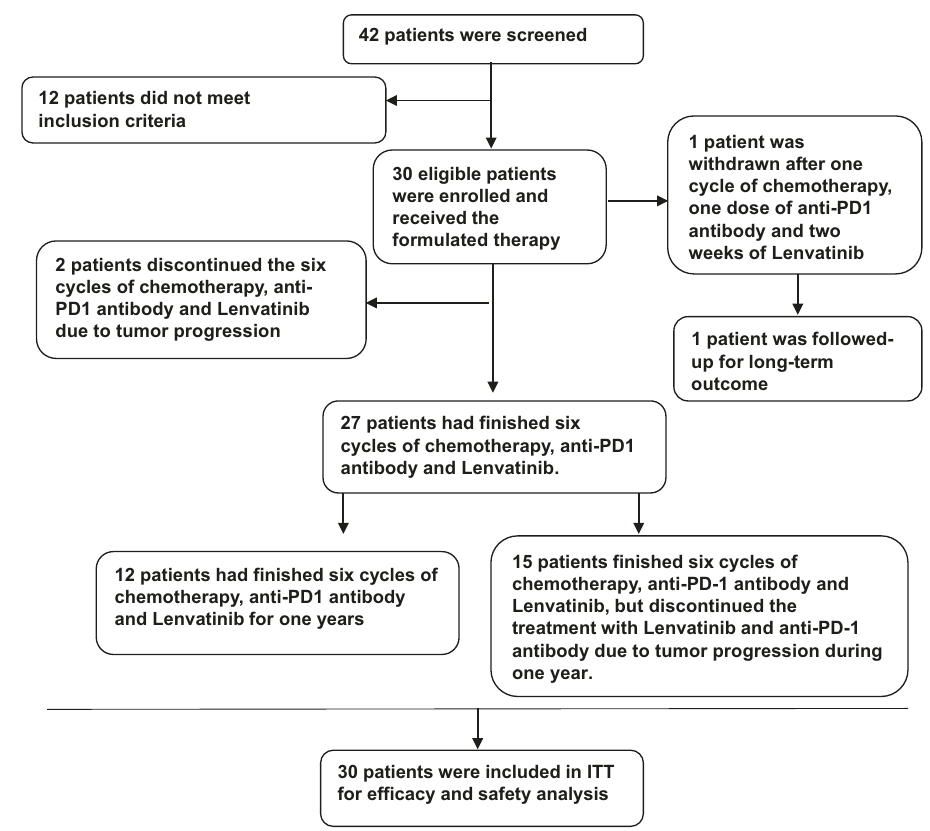
Fig. 1 Flowchart for participants ’